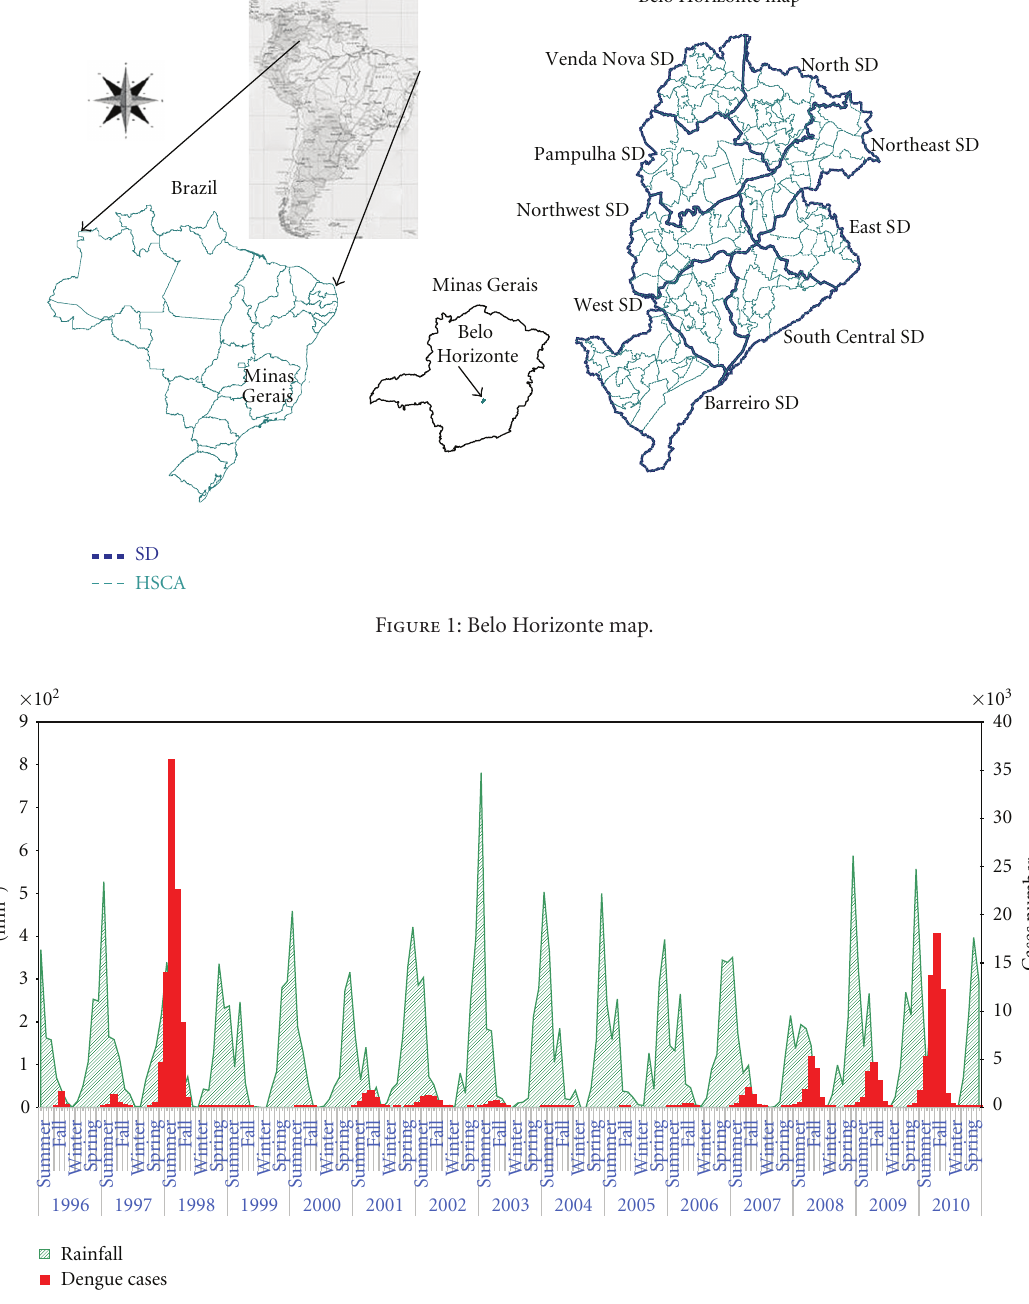
Figure 2: Dengue cases and rainfall by month, season, and year, Belo Horizonte, Minas Gerais state, Brazil, from 1996 to 2010.